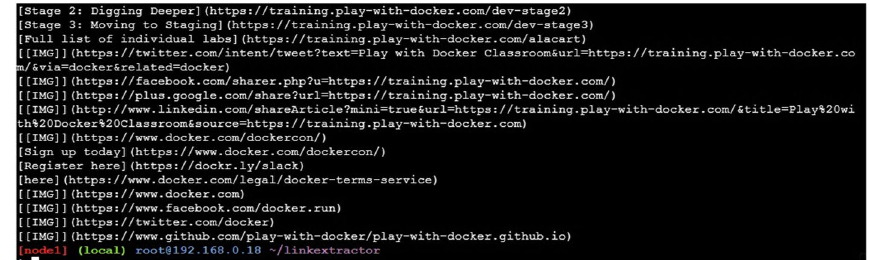
Fig. 4 Links extracted from a given URL